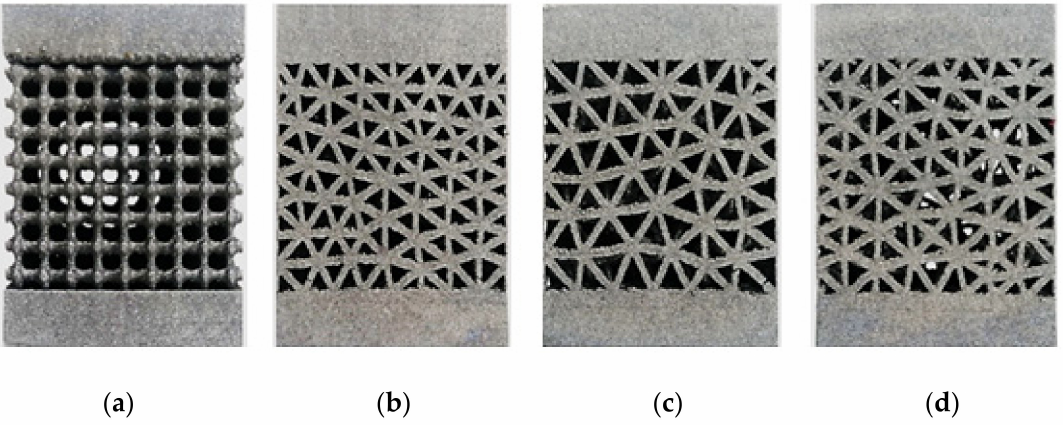
Figure 2. Manufactured specimens: ( a ) 3D lattice infill pattern, ( b ) double-pyramid lattice with cross, ( c ) double-pyramid lattice and face diagonals, ( d ) octahedral lattice 2.